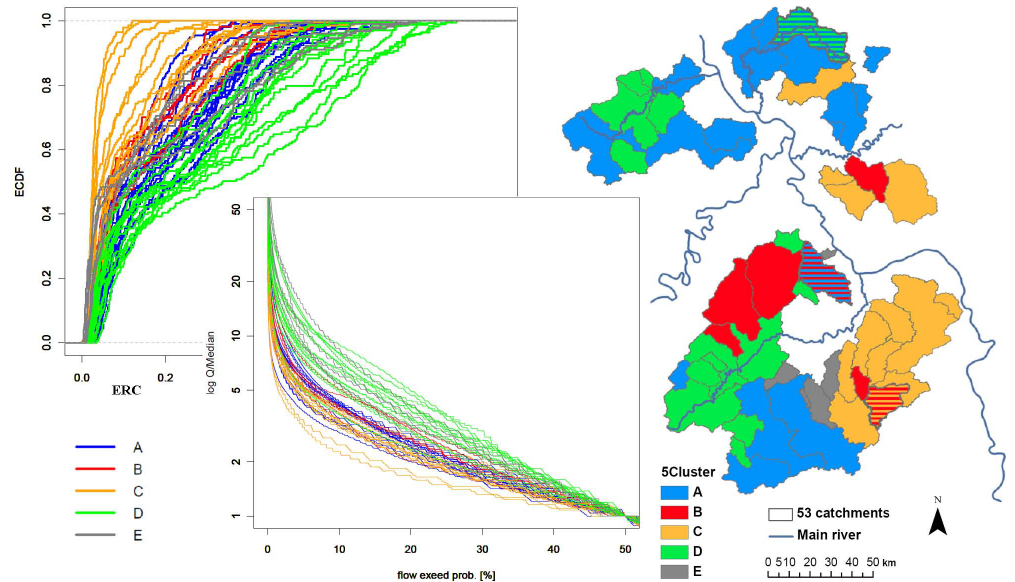
Fig. 6. Clusters by catchment response behaviour: empirical distribution function of event runoff coefficients, flow duration curve (limb < 50%) and spatial distribution. The striped catchments in the map are borderline cases, shown in colours of their first and second best cluster. Note, some catchments are nested, so their areas overlap. Smaller catchments are plotted on top of larger